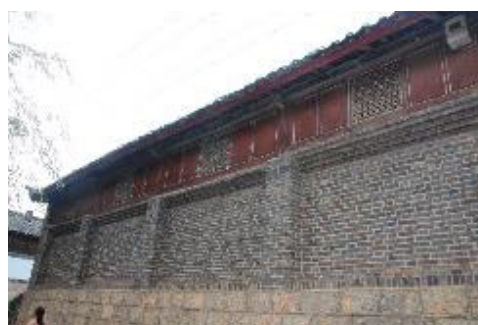
Figure 22. Walls constructed with three types of materials (photo by the first author)